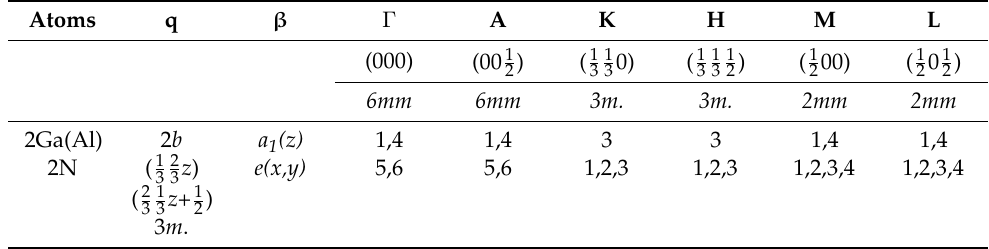
Table 1. Phonon symmetries in the bulk GaN (AlN) with the space group P6 3 mc . Pairs of conjugated